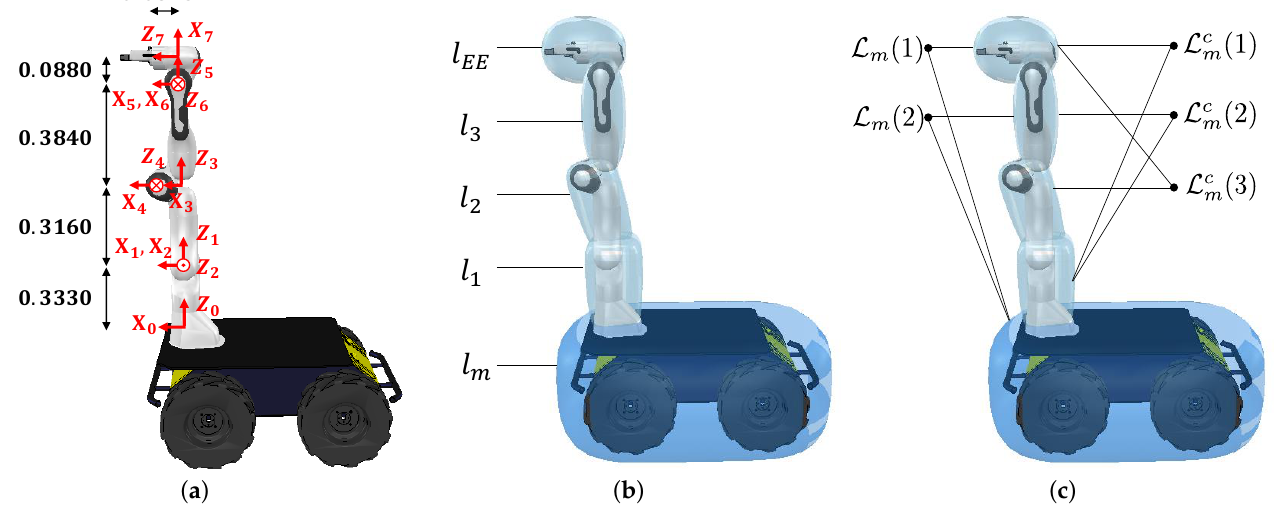
Figure 2. Our mobile manipulator system consists of a four-wheel differentially driven mobile robot called Husky (Clearpath Robotics. Co.) and 7-DOFs manipulator called Panda (Franka Emika. Co.). ( a ) Kinematic structure of the manipulator is shown with the scale of meter; ( b ) the simplified collision models of the robot consist of five links; ( c ) based on the collision models and joint range of the manipulator, all link pairs that potentially collide with each other are identified. L m ( i ) denotes the link pair including the mobile robot, whereas L c m ( j ) denotes the link pair not including the mobile